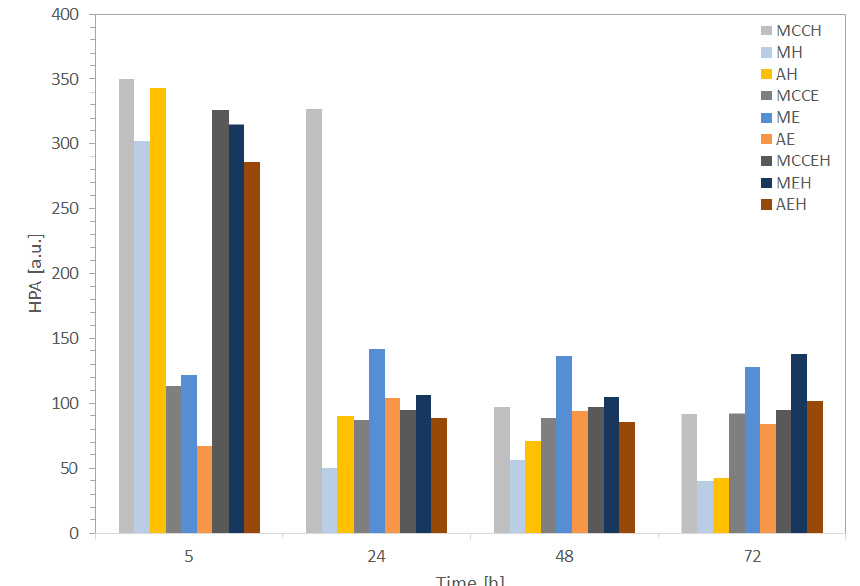
Fig. 4 Changes in hydroxyl peak area (HPA) during air-drying for MCC untreated and silane-treated (mass ratio 1:1) using tested